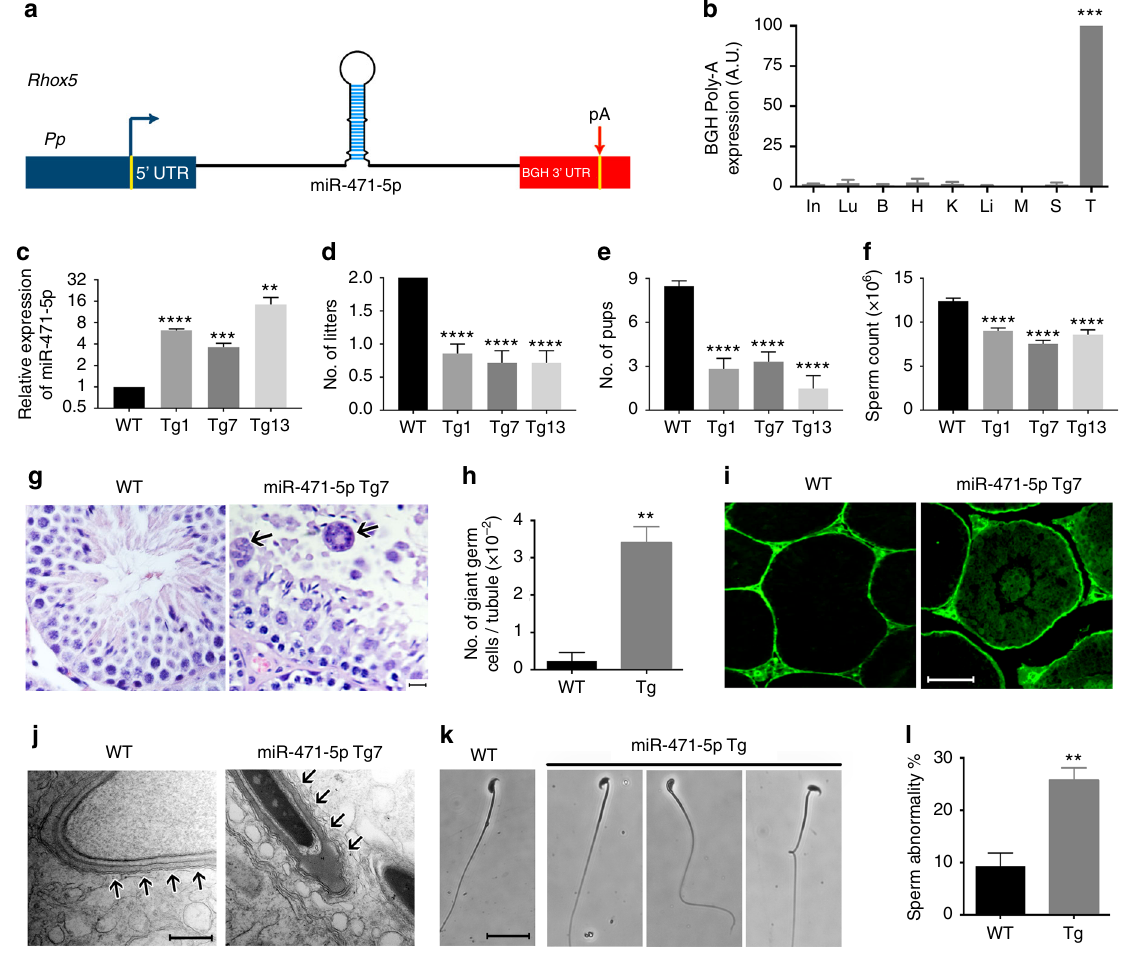
Fig. 1 Reproductive defects in miR-471-5p transgenic (Tg) mice. a Schematic of the construct used to generate miR-471-5p transgenic mice (miR-471-5pTg). Pp indicates 0.6 kb proximal promoter from Rhox5 gene. MiR-471 represents primary sequence of miR-471-5p. pA represents bovine growth hormone polyA sequence. b qRT-PCR analyses of RNA isolated from the vital organs of miR-471-5p Tg using BGH polyA primers. *** p = 0.0002, one-way ANOVA followed by Dunnett ’ s multiple comparisons test. c qRT-PCR was used to quantitate the levels of mature miR-471-5p in total testicular RNA from three transgenic lines (Tg1, Tg7, and Tg13) and normal control mice (wild-type; WT ). Bar graph represents average fold increase of miR-471-5p expression over endogenous miR-471-5p levels. Expression normalized to RNU19 or 5S; **** p < 0.0001,*** p = 0.001, ** p = 0.0036; two-tailed unpaired student t -test. d , e Total number of litters ( d ) and pups per litter ( e ) obtained from 2 months mating between control male and control female (WT) and between miR-471-5pTg male (from Tg1, 7 and 13 lines) with control female littermates ( n = 10 for WT; and n = 10 for each of the three miR-471-5p transgenic lines). **** p < 0.0001; one-way ANOVA followed by Dunnett ’ s multiple comparisons test. f Caudal sperm count in miR-471-5p Tg and control (WT) mice ( n = 7 for WT and n = 7 for miR-471-5pTg mice), **** p < 0.0001; one-way ANOVA followed by Dunnett ’ s multiple comparisons test. g Hematoxylin and eosin-stained sections of testes of control (WT) and miR-471-5pTg mice (line Tg7). Arrows indicate multinucleated giant germ cells in miR-471-5pTg mice testis. h Average number of giant cells per tubule in testes of control (WT) and miR-471-5pTg mice, ** p = 0.0023, two-tailed unpaired student t -test. i Appearance of biotin tracer dye in the adluminal compartment of some seminiferous tubules of miR-471-5pTg mice suggests a leaky blood – testis barrier. Wild-type ( WT ) control mice show restriction of biotin tracer to the basal compartment. j Ultrastructural defects in miR-471-5pTg (line Tg7) mice testis. Transmission electron microscopy of testicular section from control mouse shows normal morphology. The acrosome extends over the apex and over the dorsal curvature of the head. Apical ectoplasmic specialization is well recognized and is seen over the entire acrosome region. Testicular sections from miR-471-5pTg mice show disruption and loss of apical ES ( arrows ). k Phase-contrast microscopy of sperm shows abnormal head/tail morphology in miR-471-5pTg mice. l Histogram shows average number of abnormal spermatozoa in miR-471-5p Tg (average of Tg1, Tg7, and Tg13 lines, 3 animals/line) and normal control (WT) mice; ** p = 0.0044, two-tailed unpaired student t -test. Scale bar indicates 50 μ m g , i ), 500 nm ( j ), 25 μ m ( k ). ANOVA: analysis of variance. In = Intestine; Lu = Lungs; B = Brain; H = Heart; K = Kidney; Li = Liver; M = Muscle; S = Spleen; T =